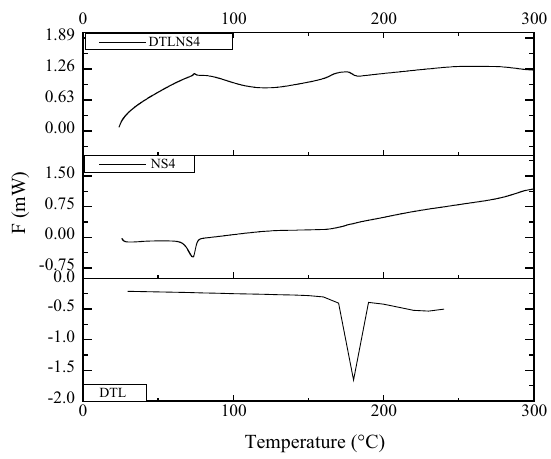
Fig. 6 DSC thermogram of DTL (dithranol), NS4 (nanosponges formulation) and DTLNS4 dithranol